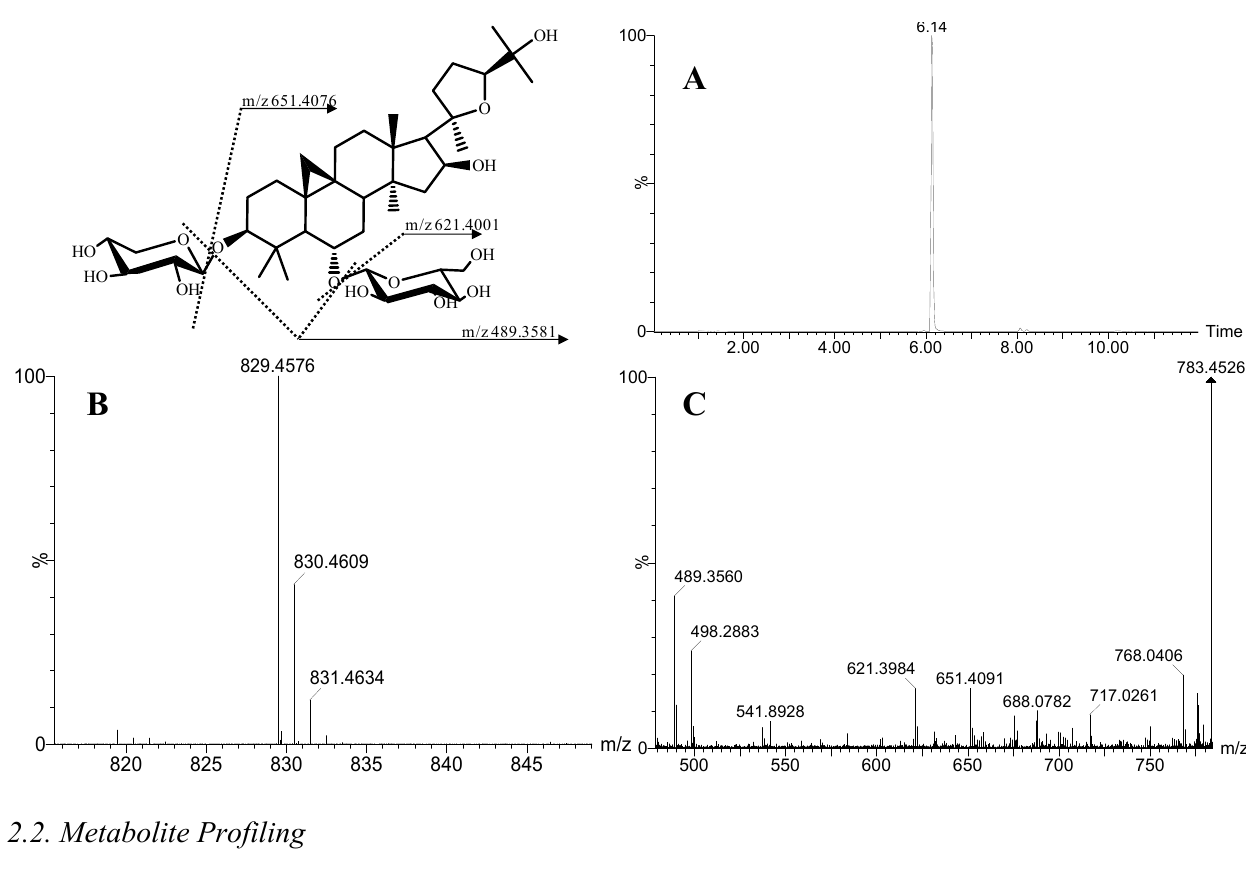
Figure 1. The XICs ( A ), MS ( B ) and MS/MS ( C ) spectra of astragaloside